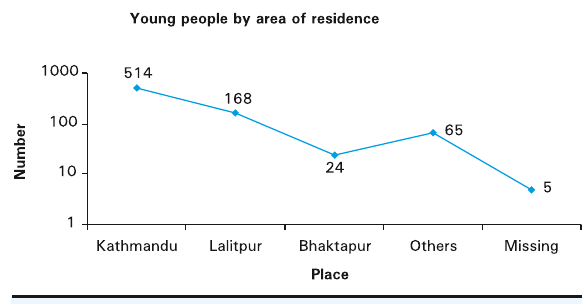
Figure 2. Prevelance according to thier